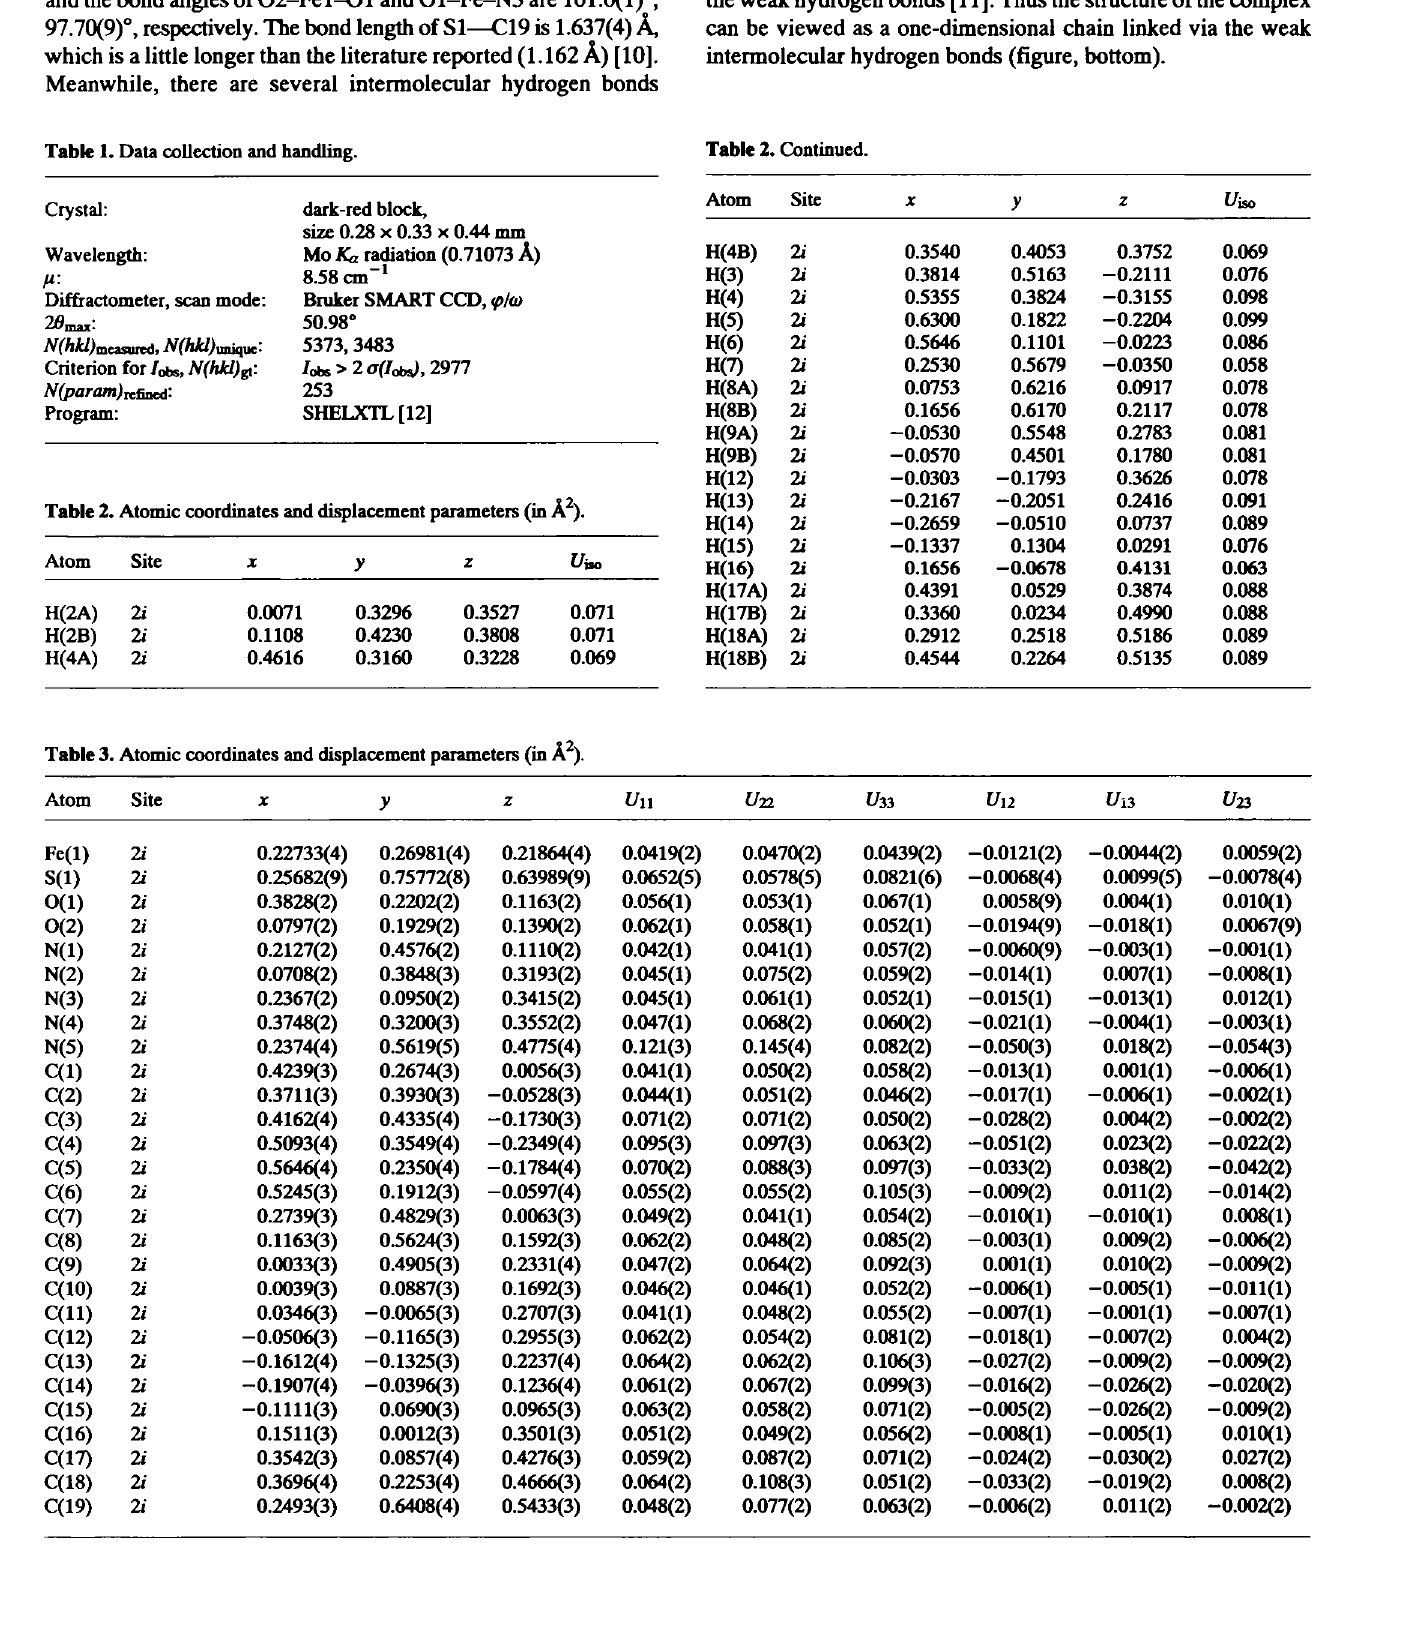
Table 1. Data collection and handling.